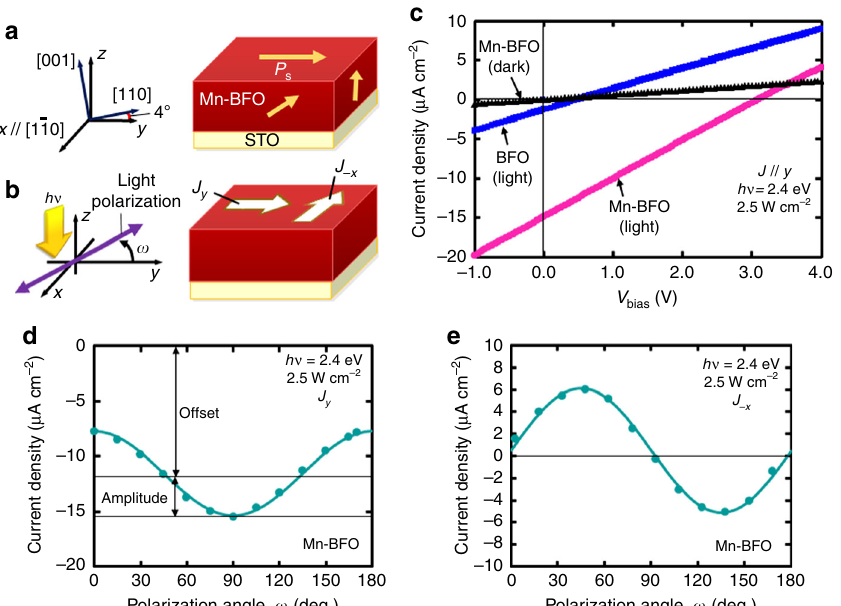
(deg.)120 150 180 Polarization angle, (cid:2) (deg.) Polarization angle, (cid:2) Fig. 3 Measurement con fi guration and photovoltaic (PV) properties of the Mn-BFO fi lm. a Schematic of the single-domain (SD) structure associated with the pseudocubic [ hkl ] directions exhibiting the crystallographic orientations with respect to the lab-coordinate ( xyz ) system. The x axis lies along ½ 110 (cid:2) , and the y and z axes are 4° away from [110] and [001], respectively. b PV measurement con fi guration in which polarized light with photon energy hv propagates along the z axis and is incident on the sample surface. The incident light has a polarization angle ( ω ) from the y axis in the xy plane. The short- circuit current density ( J sc ) and open-circuit voltage ( V oc ) along the m direction are expressed as J m and V m , respectively. A positive J m indicates that the photocurrent fl ows in the m direction. The bias voltage ( V bias ) at which the current density ( J ) becomes zero is denoted by − V m . c Current density – bias voltage ( J – V bias ) properties along the y direction under dark and illuminated ( hv = 2.4 eV) conditions, where the polarization angle ω is aligned so that the PV response becomes maximum for both the BFO and Mn-BFO (Mn 5%) fi lms. Light polarization angle ω dependences of short-circuit currents d J y and e J − x in the Mn-BFO fi